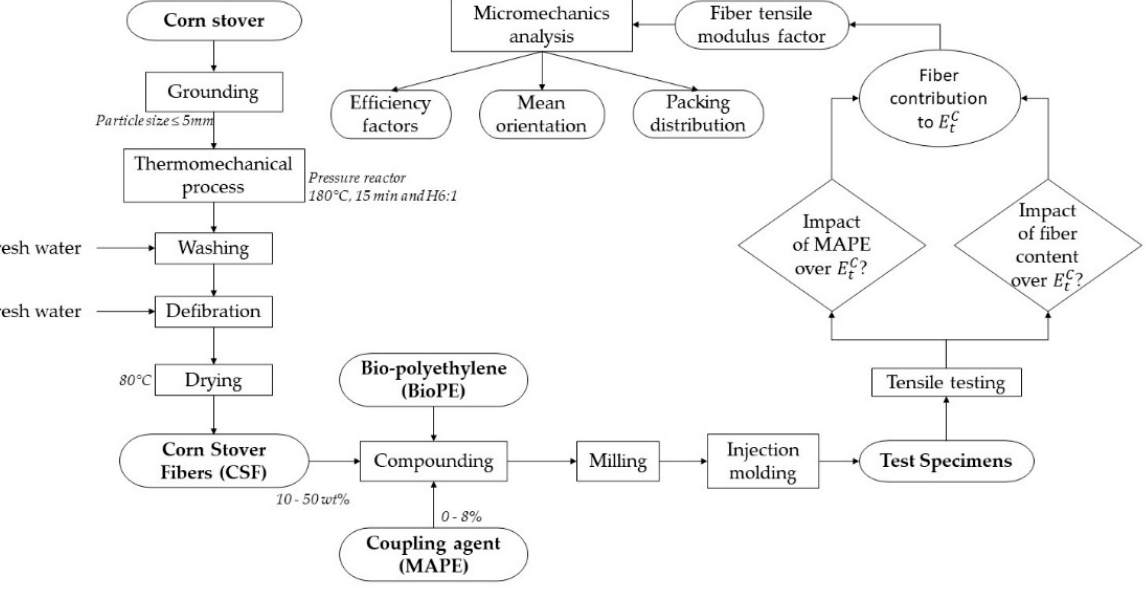
Figure 1. General flow diagram of the present